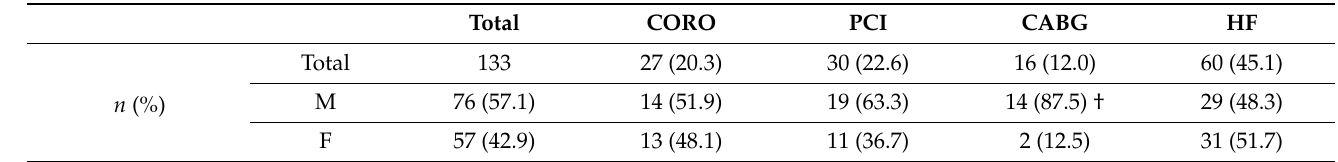
Table 1. Baseline characteristics of the study population according to sex and